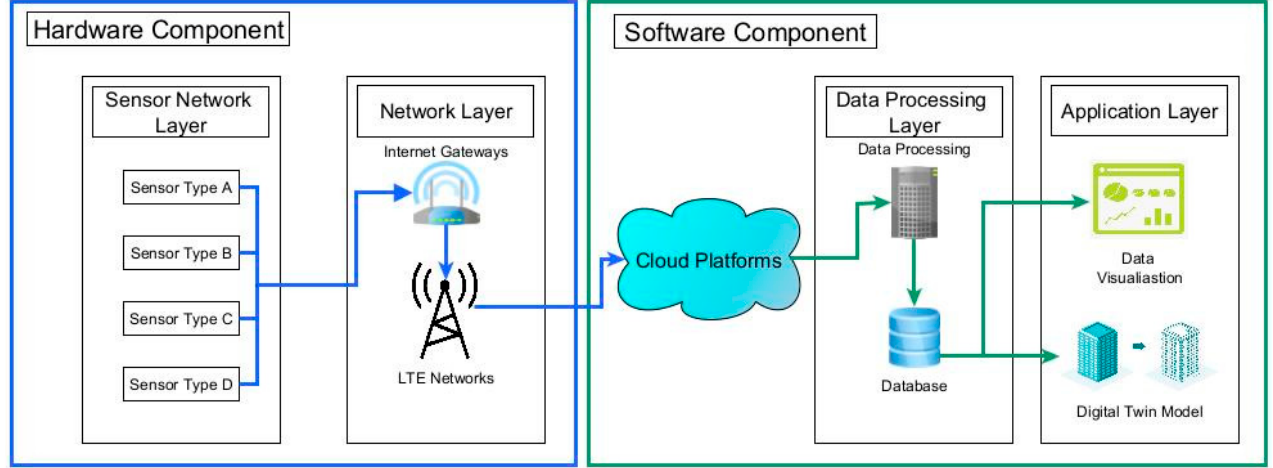
Figure 1. An architecture-level diagram of the monitoring system from sensor and network devices to cloud platforms for data storage and visualization.